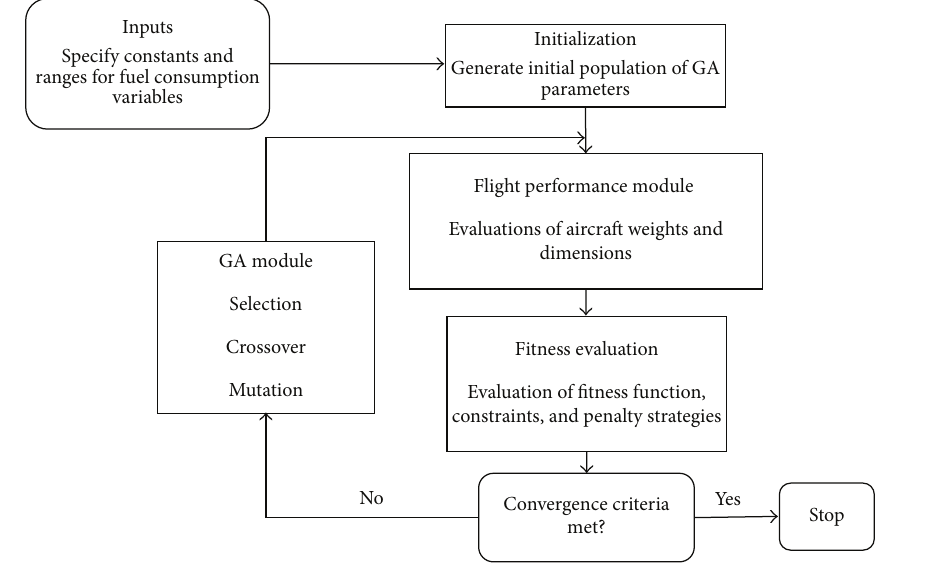
Figure 2: Flow chart of genetic